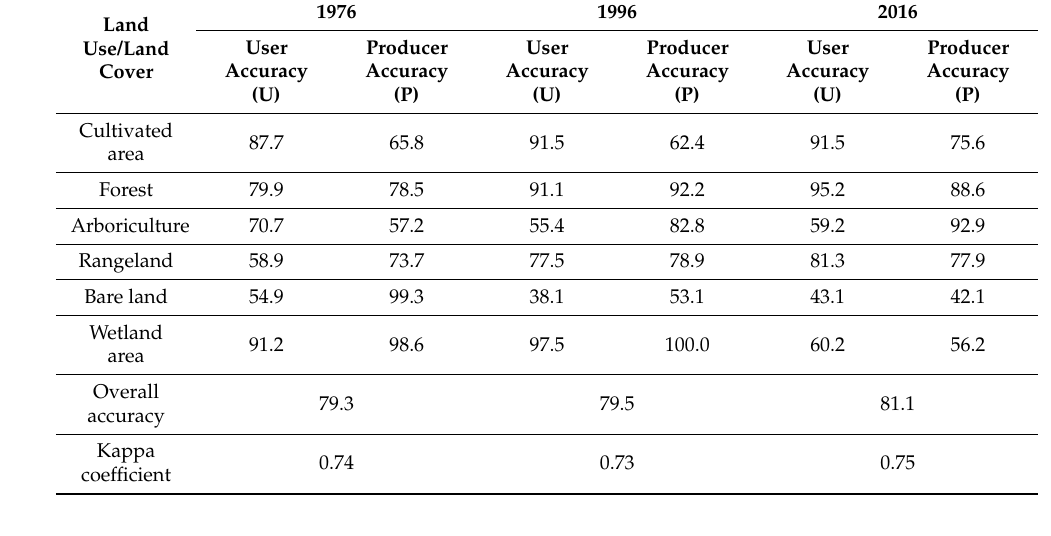
Table 3. Accuracy assessments for land use/land cover classification (%) (1976–2016).